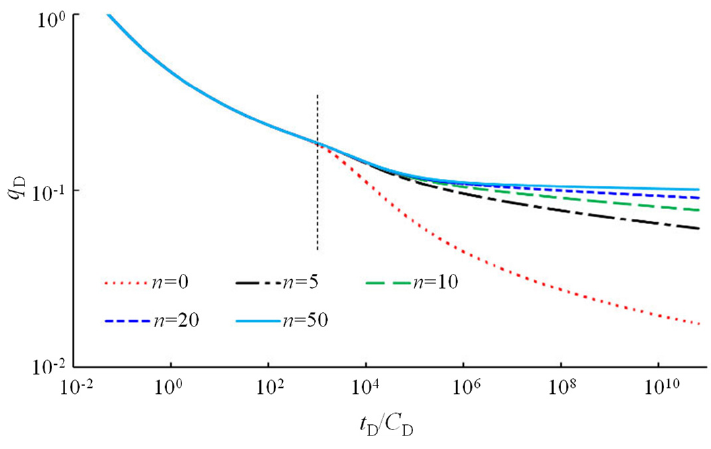
Figure 5. The effect of finite water-body multiple on productivity.